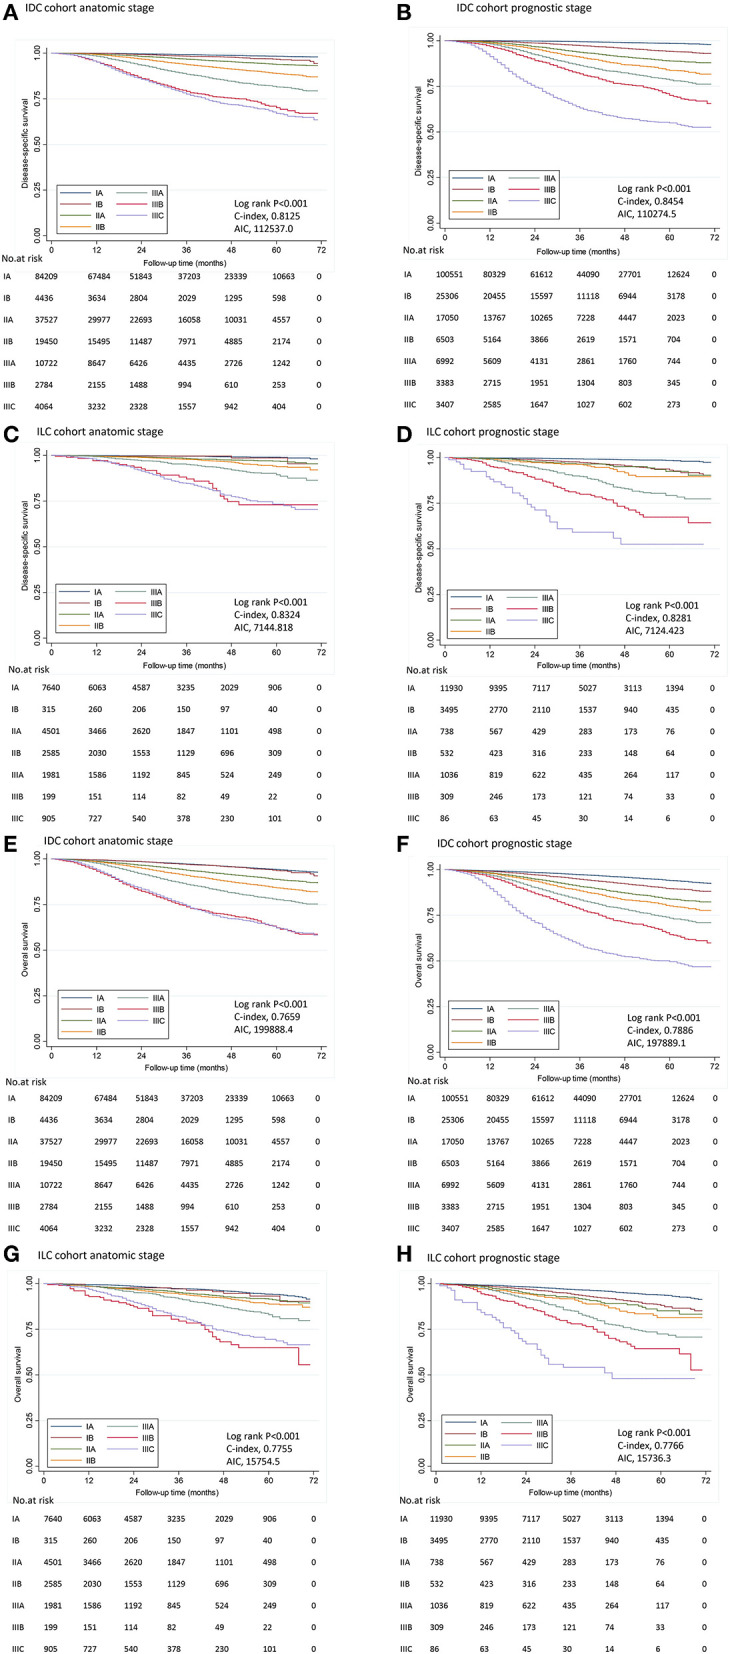
Disease-specific survival and overall survival by stage in IDC and ILC cohort. Kaplan–Meier survival plots demonstrated DSS (A–D) and OS (E–H) in different stages determined by the 8th AJCC staging manual in IDC cohort and ILC cohort. IDC, invasive ductal carcinoma; ILC, invasive lobular carcinoma; AIC, Akaike information criterion.